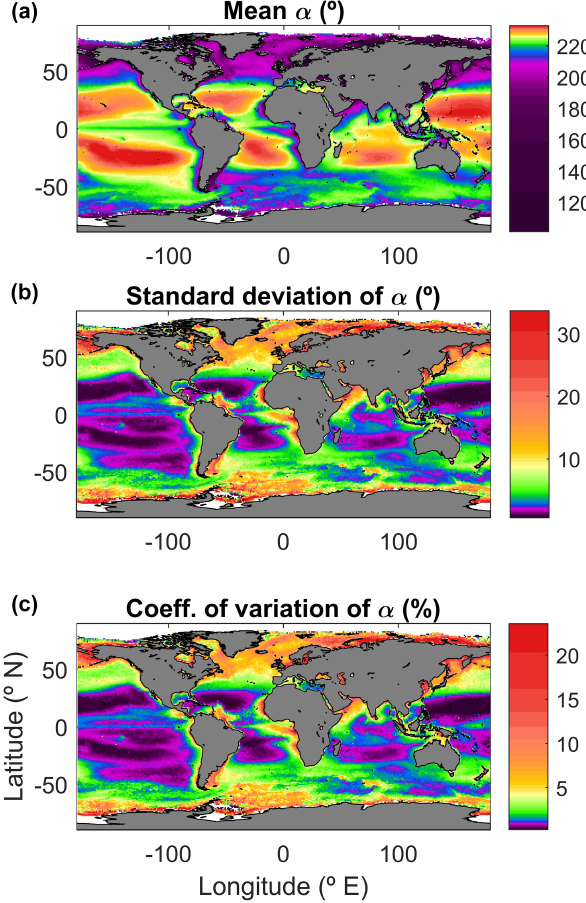
Figure 3. Global maps of the hue angle ( α ) in the period 1997– 2018. (a) Series mean. (b) Standard deviation. (c) Coefficient of